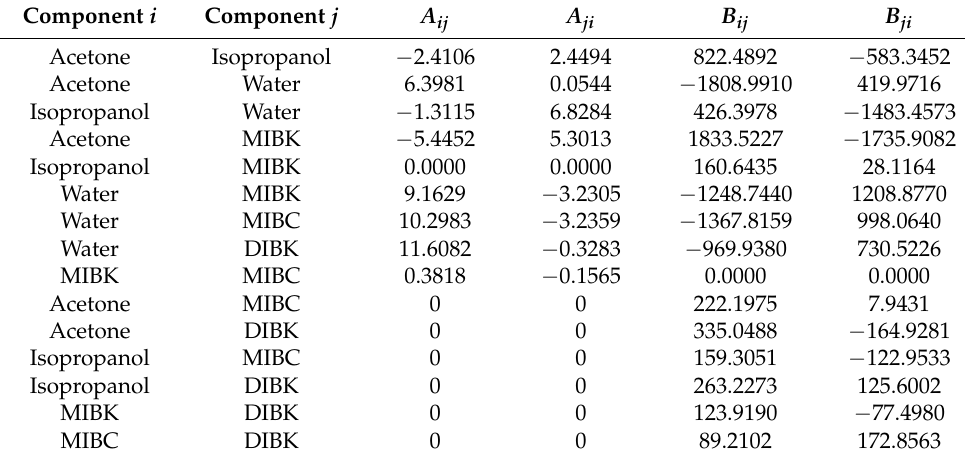
Table 3. NRTL parameters for binary systems.